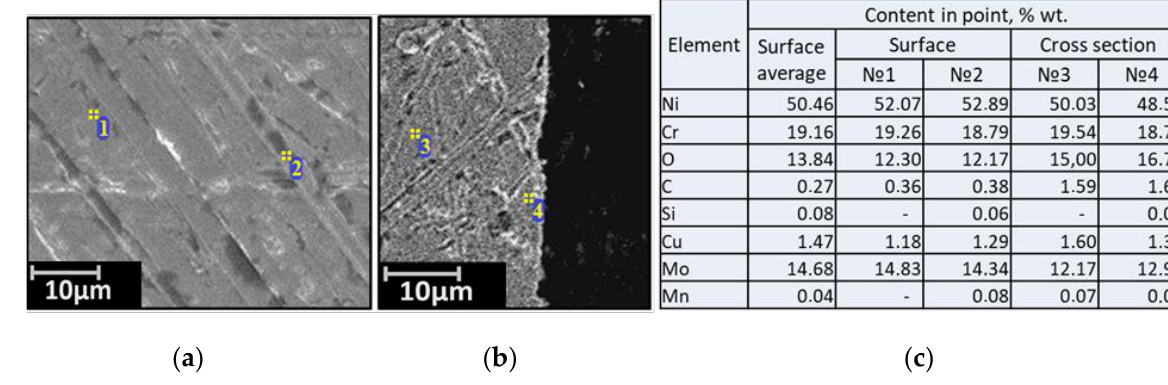
Figure 2. Micrographs of the surface ( a ), the cross-section ( b ), and the elemental composition ( c ) of the source material Hastelloy C2000.